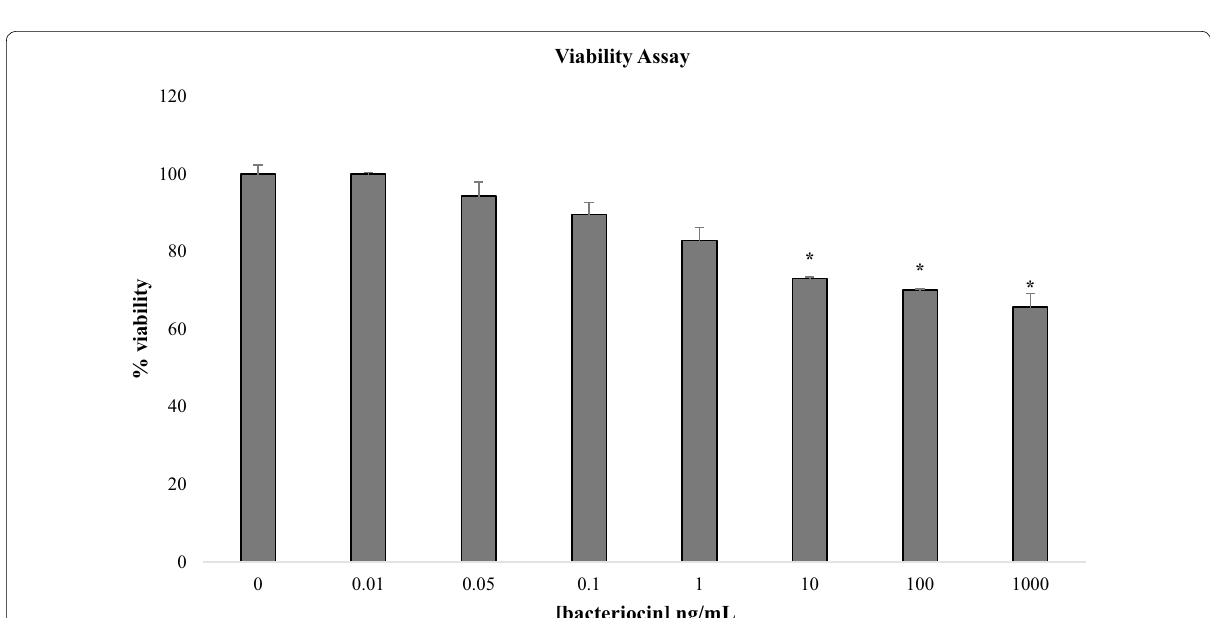
Fig. 8 Evaluation of cell viability on E705 cancer colon cell line after treatment with plantaricin P1053. MTT test was performed on cancerogenic E705 cell line. Buffer NaCl 0.1 M pH 2 was used as control and it did not have any effect on cell viability (100% viability). Values are presented as mean SD. Statistical analyses were performed using the Student’s t-test. * p < ±